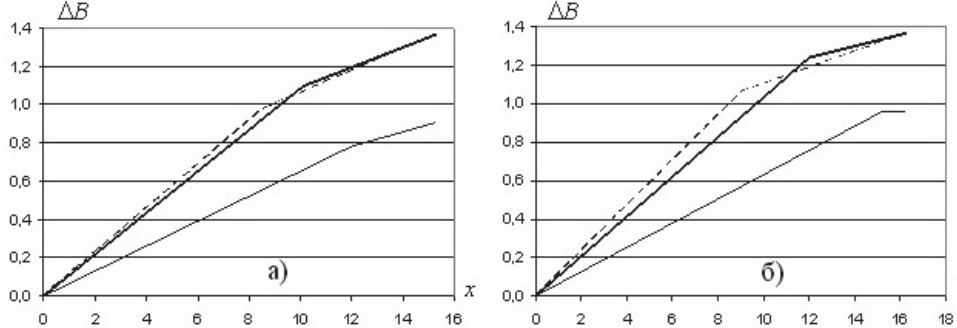
Figure 3: Effect of the anterior and posterior tension on broadening (the conditions of experiment 1, b) the conditions of experiment